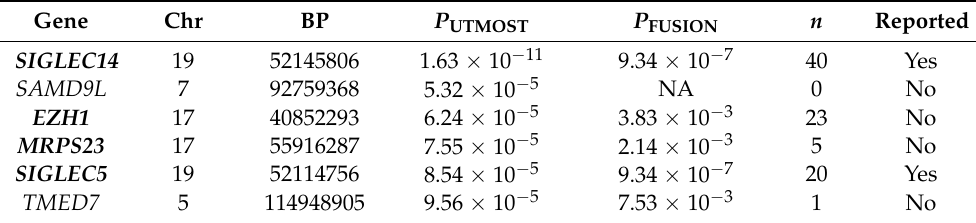
Table 1. Significant genes in the TWAS analysis of periodontitis.